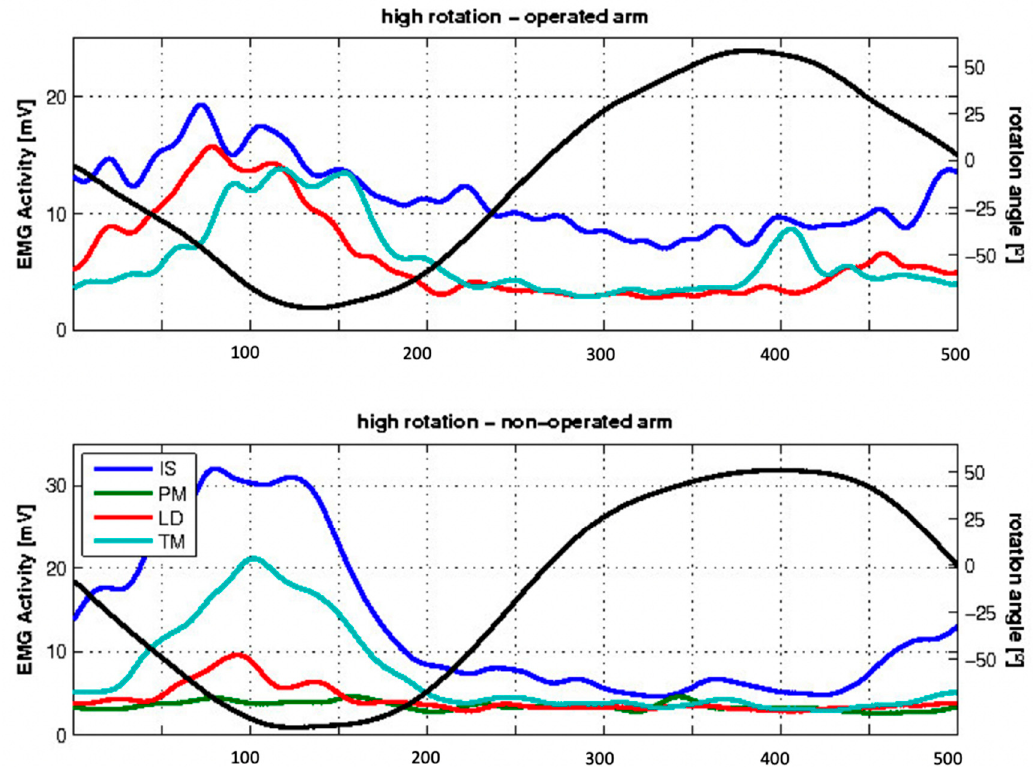
Figure 4. Mean EMG activity of the examined patients during high exorotation. The x-axis indicates the frames; the y-axis indicates, on the left side, the EMG activity in mV for the different muscles (IS, PM, LD, and TM), in colored lines and, on the right side, the angle of rotation, represented by the black line. Negative values show exorotation, and positive values endorotation.